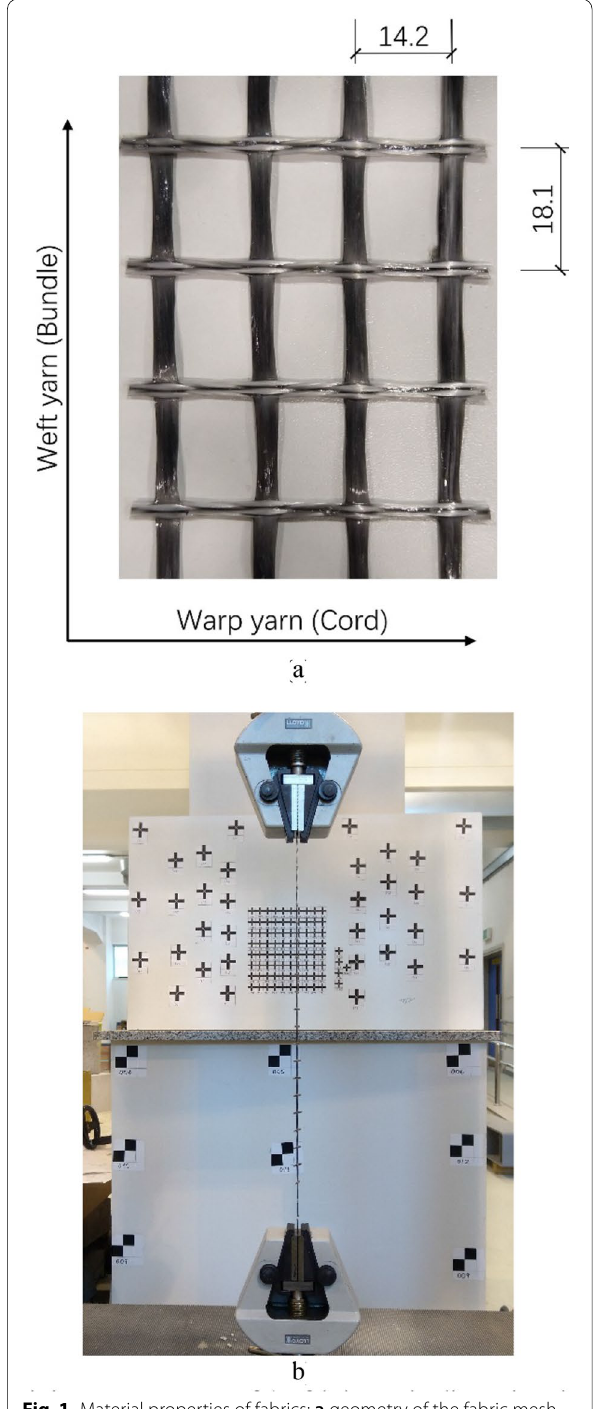
Fig. 1 Material properties of fabrics: a geometry of the fabric mesh [dimensions in mm]; b direct tensile test of one